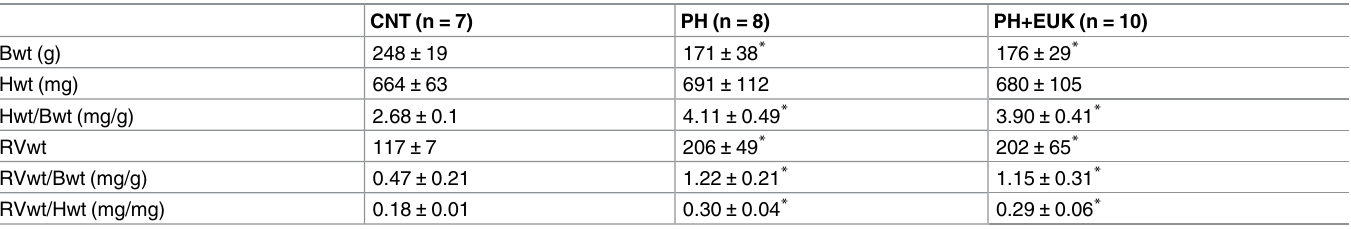
Table 1. Body and heart weights.